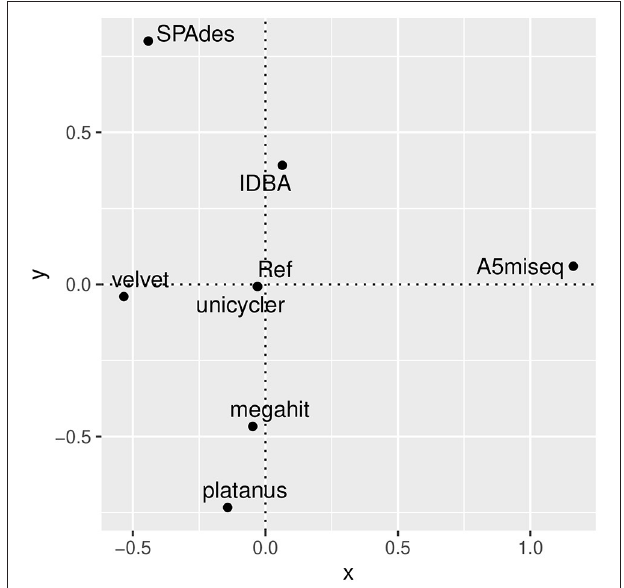
FIGURE 9 | Non-metric multidimensional scaling (NMDS) plot in the edit distance space of the reference and monomer consensus contigs reconstructed with the seven assembly programs using the mds function of smacof library. Note that Unicycler was located at the same place with the reference